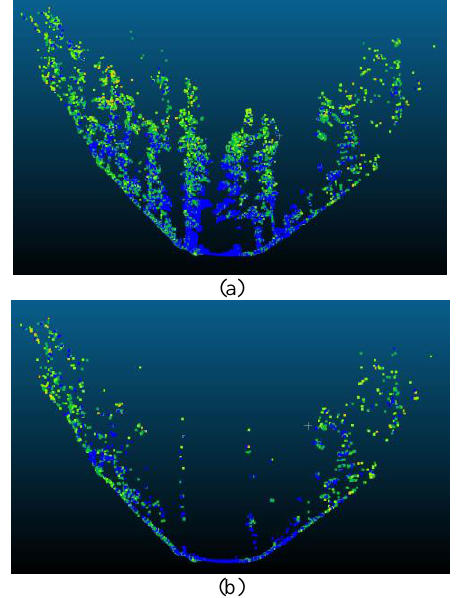
Figure 3. Profile views colored by echoes (blue (first echo) – green – yellow – red (last)): (a) row point cloud from 1 scanner (b) filtered point cloud with attributes – (0.15 x 0.15) m cell and smallest Z-value from 1 scanner